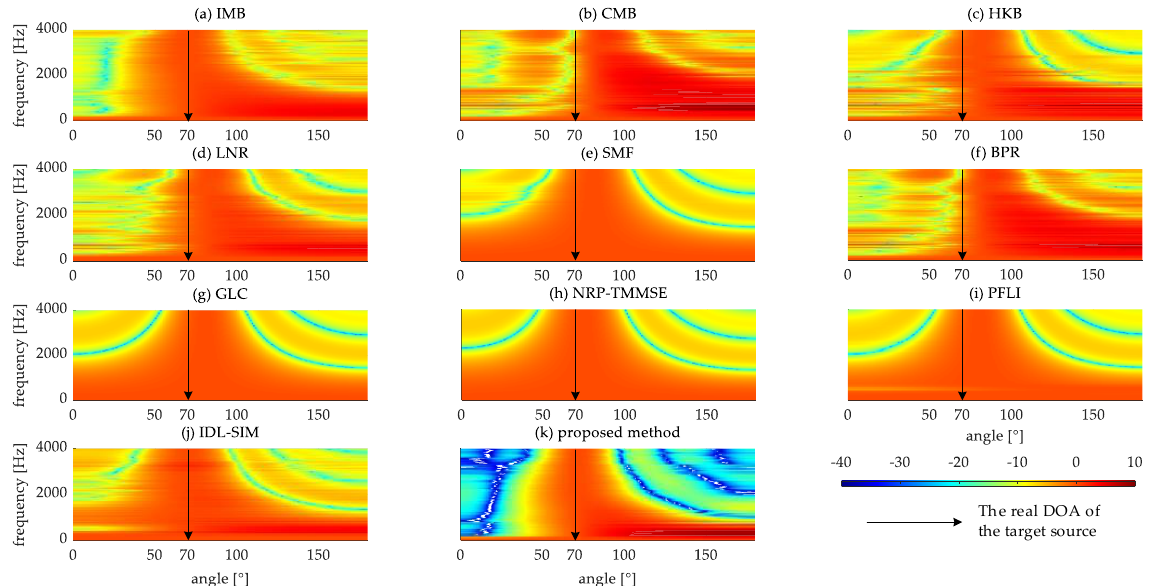
Figure 3. A comparison of beampatterns. The number of snapshots was 100 and the SNR was 10 dB.